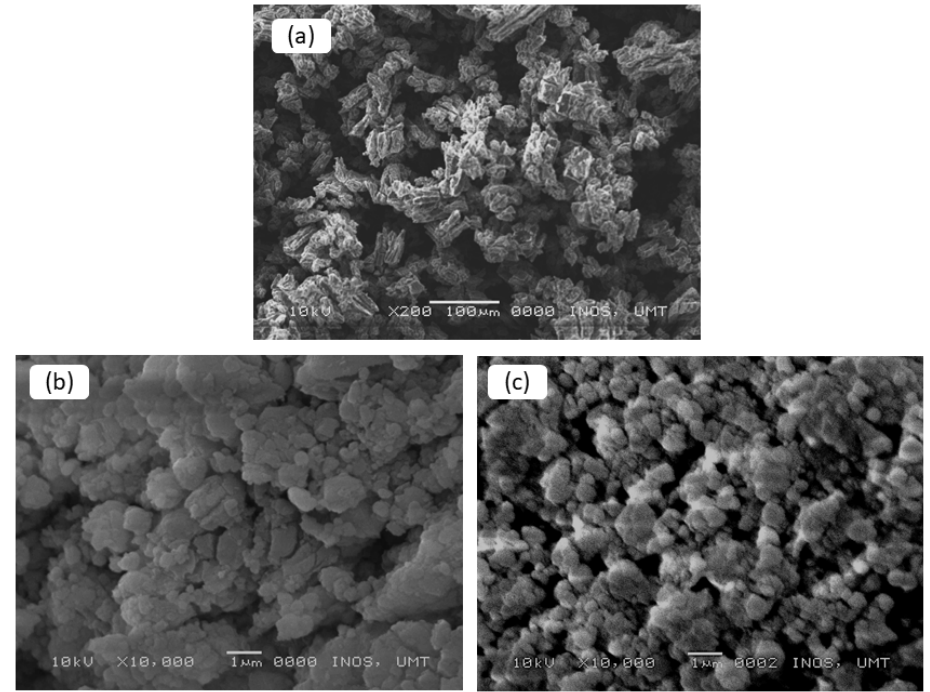
Figure 6. SEM images of ( a ) commercial LiAlH 4 , ( b ) as-milled LiAlH 4 and ( c ) LiAlH 4 + 10 wt.% CoTiO 3 sample.